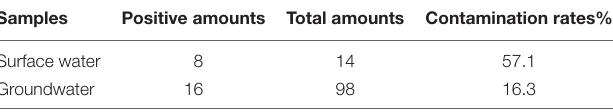
TABLE 3 | Prevalence of E. faecalis in surface water and groundwater.